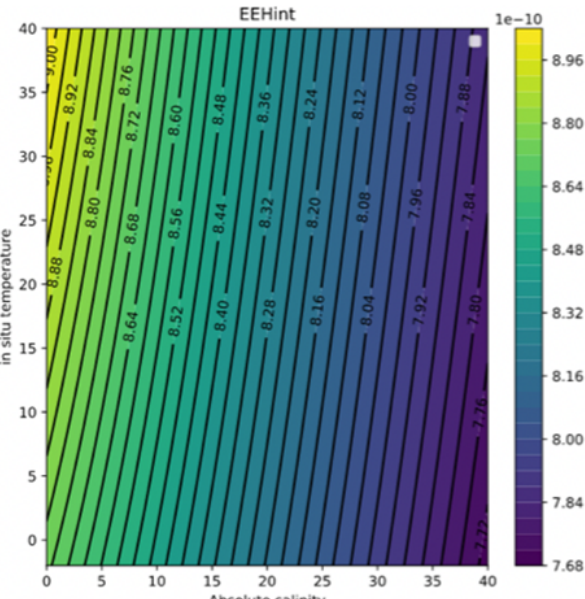
Figure B1. Integrated expansion efficiency of heat (IEEH) dependence on in situ temperature and absolute salinity at 1atm in mmJ − 1 .